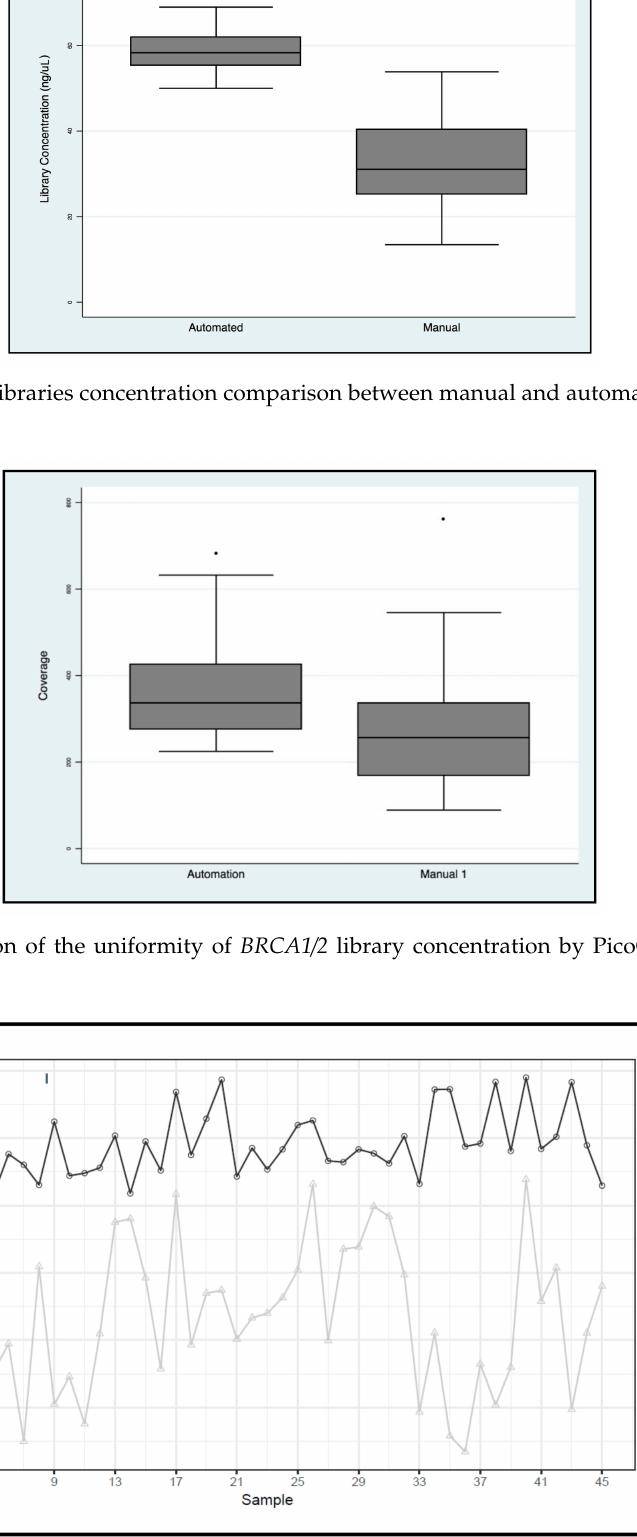
Figure 9. Next generation sequencing (NGS) coverage comparison of manual protocols vs. automated protocols for the BRCA1 / 2